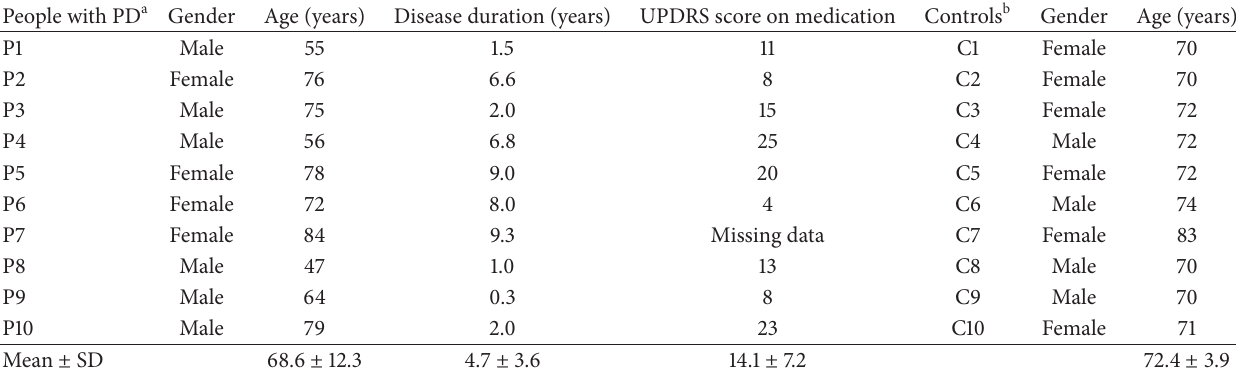
Table 1: Demographics and characteristics of people with PD and control